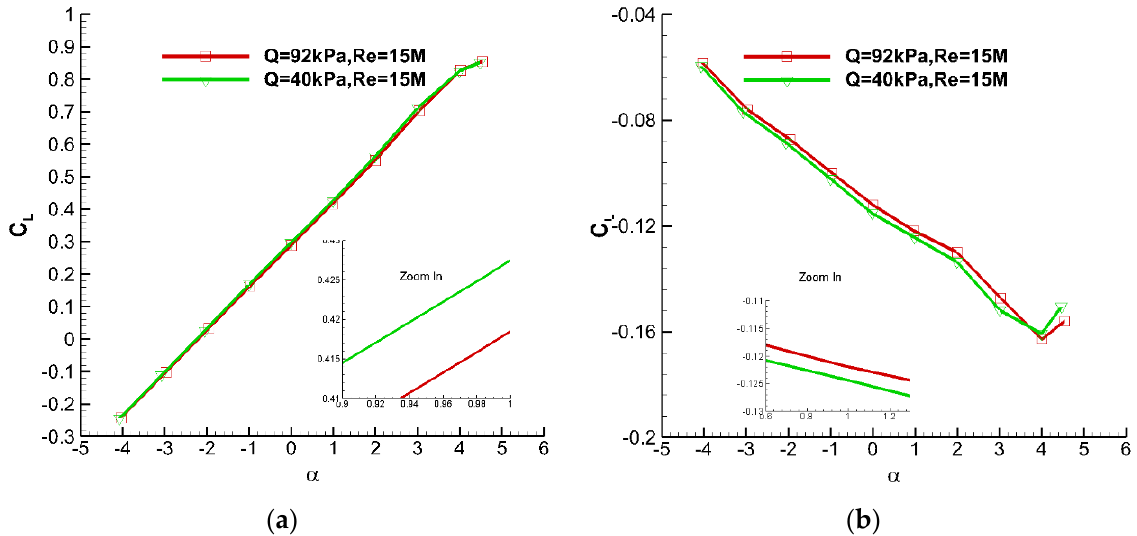
Figure 4. Longitudinal aerodynamic characteristics under different dynamic pressures (M = 0.76, Re = 15 × 10 6 ): ( a ) lift coefficient; ( b ) pitching moment coefficient.